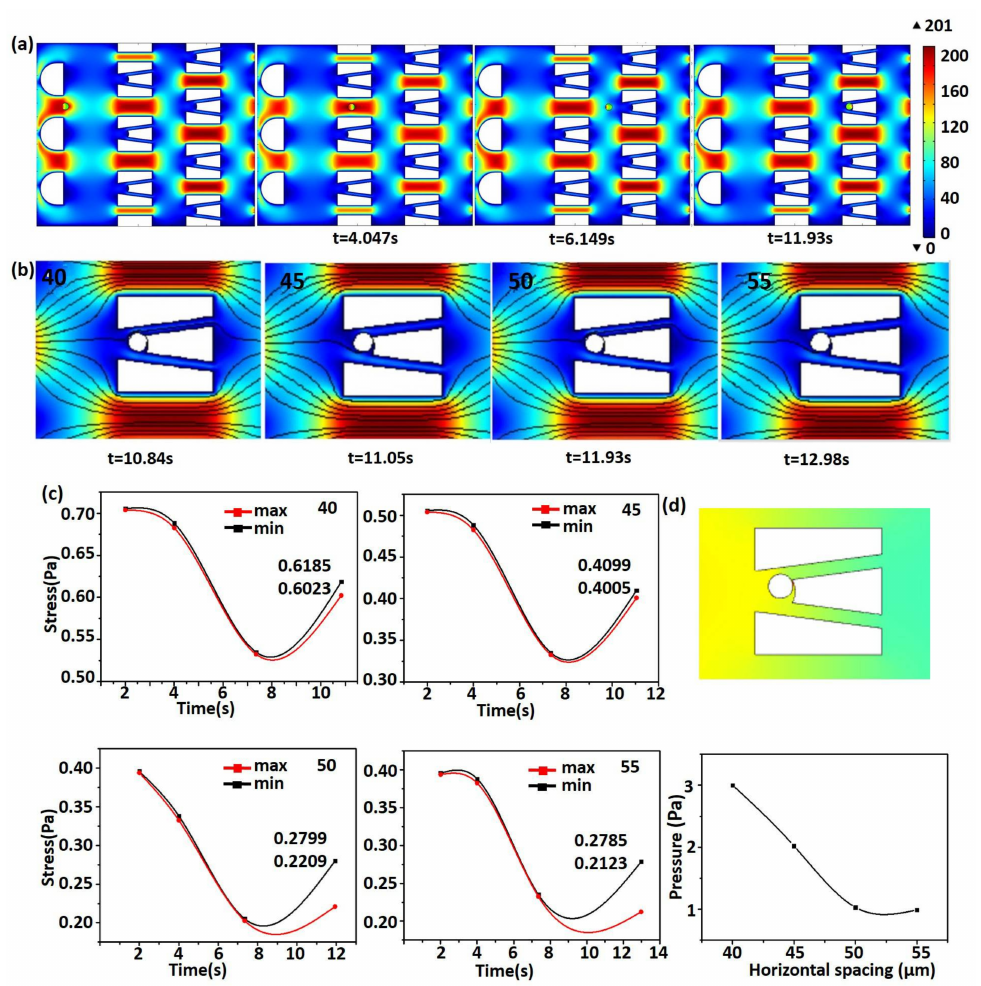
Figure 4. ( a ) The movement of the microsphere at the horizontal spacing of 50 µ m; ( b ) The final capture of the microsphere in different horizontal spacings (40, 45, 50, 55 µ m, left to right); ( c ) The stress of the microsphere in different horizontal spacings; ( d ) The fluid pressure in different horizontal